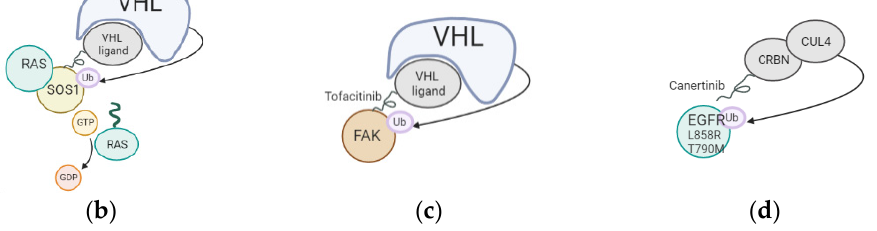
Figure 1. Mechanism of action of PROTACs tested in lung cancer. ( a ) Targeting of KRAS G12C oncogenic mutation using a Cereblon-based PROTAC; ( b ) Targeting of SOS1, cofactor of KRAS, using a VHL-based PROTAC; ( c ) Targeting of FAK using a VHL-based PROTAC; ( d ) Targeting of EGFR L858R and T790M using a CRBN-based PROTAC. Table 3. PROTACs tested in lung cancer with details of degrader and recruited